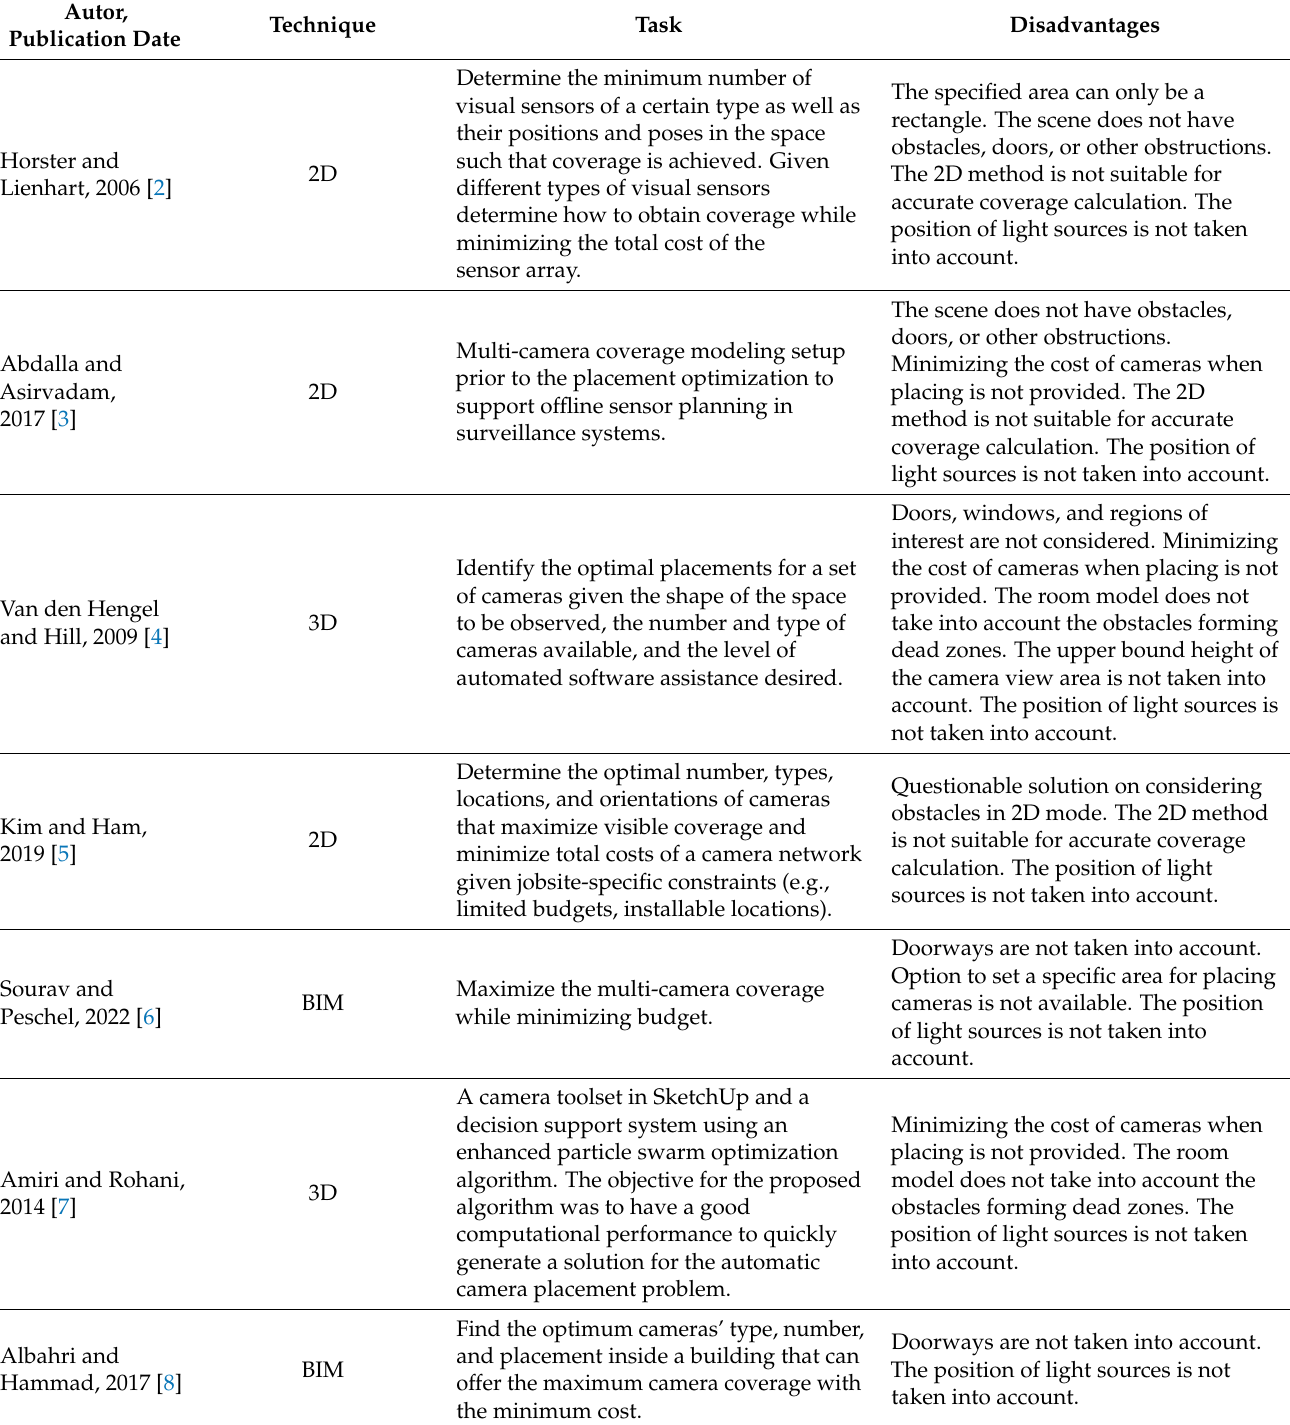
Table 1. Methods for solving the problem of automatic camera